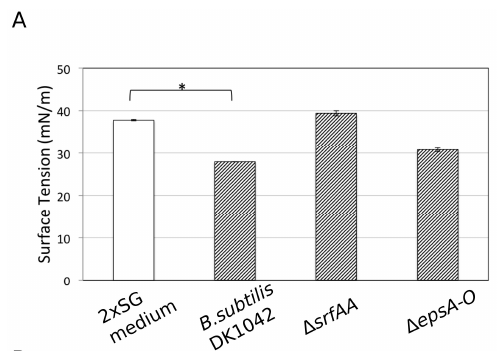
Figure 5. Cont. Figure 5. Cont.